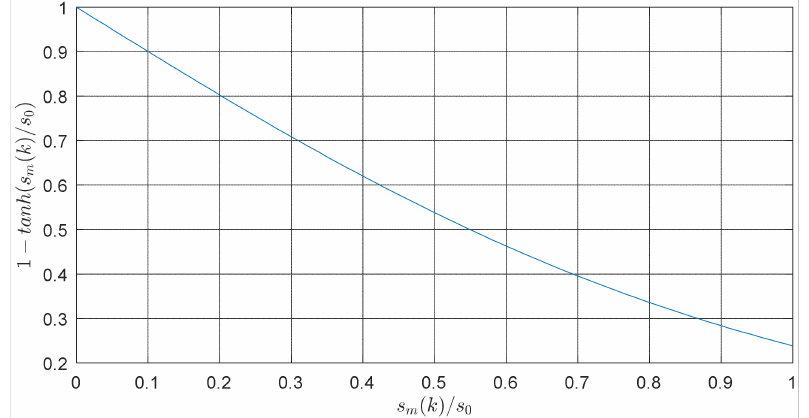
Figure 1. Evolution of 1 − α ( k